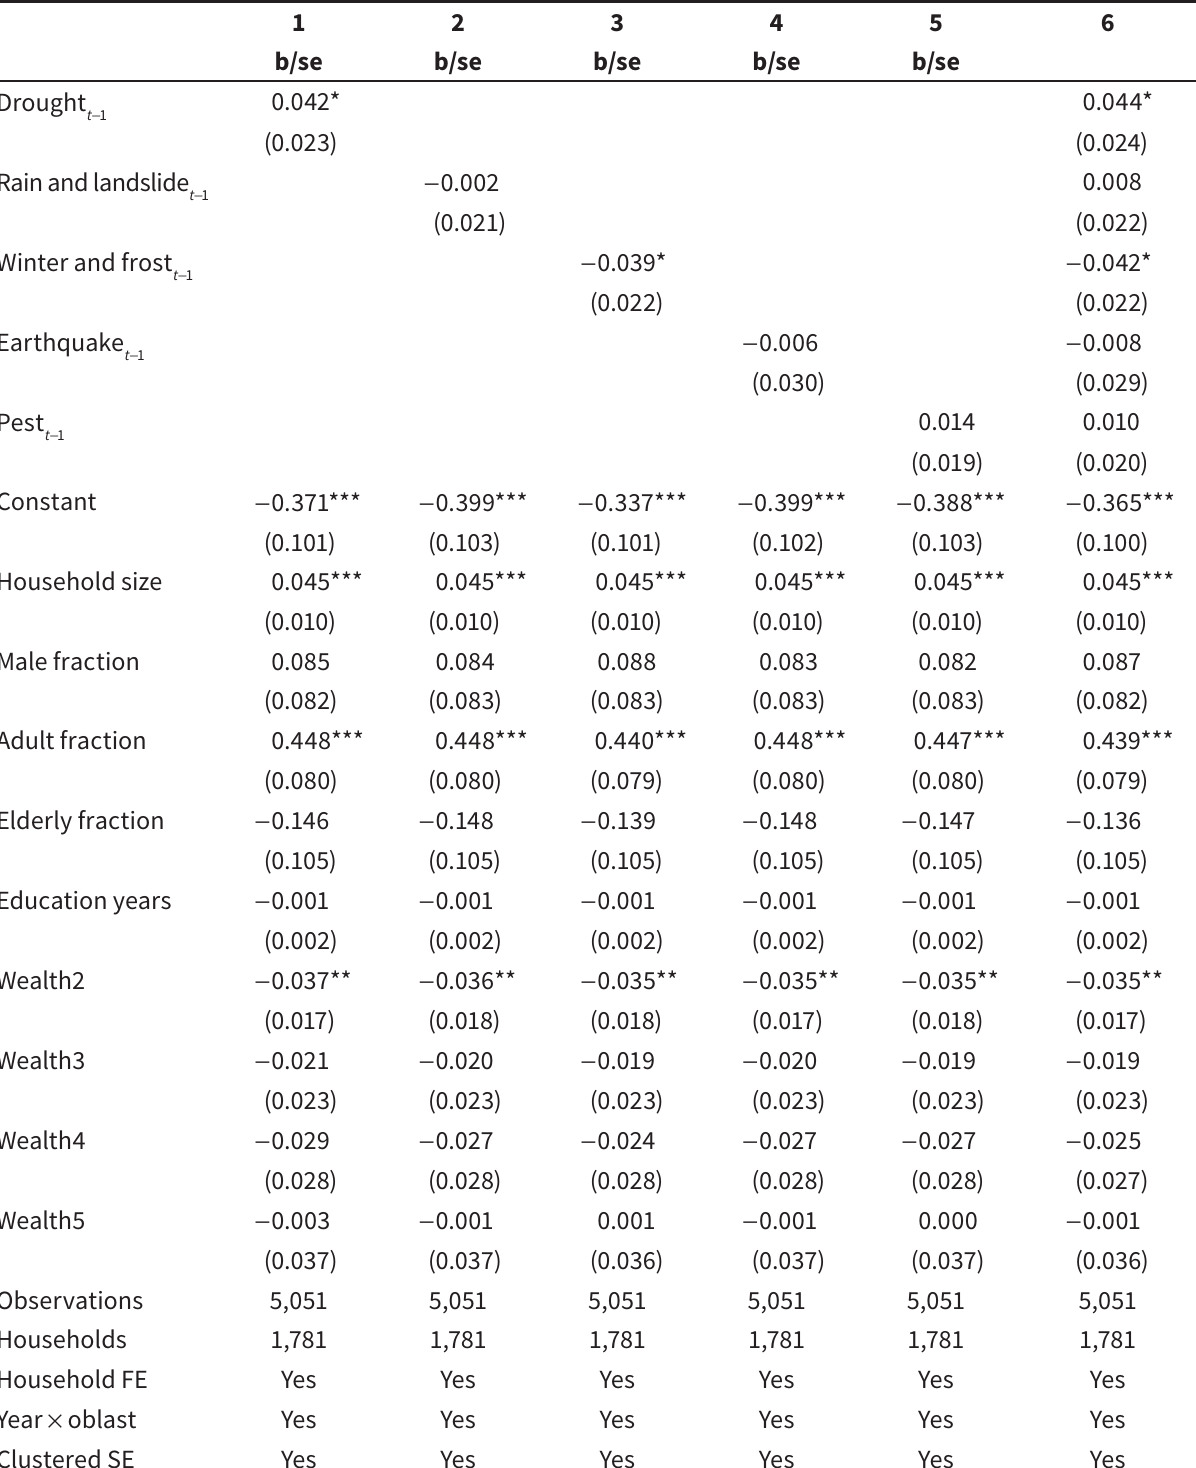
Migration and shocks with